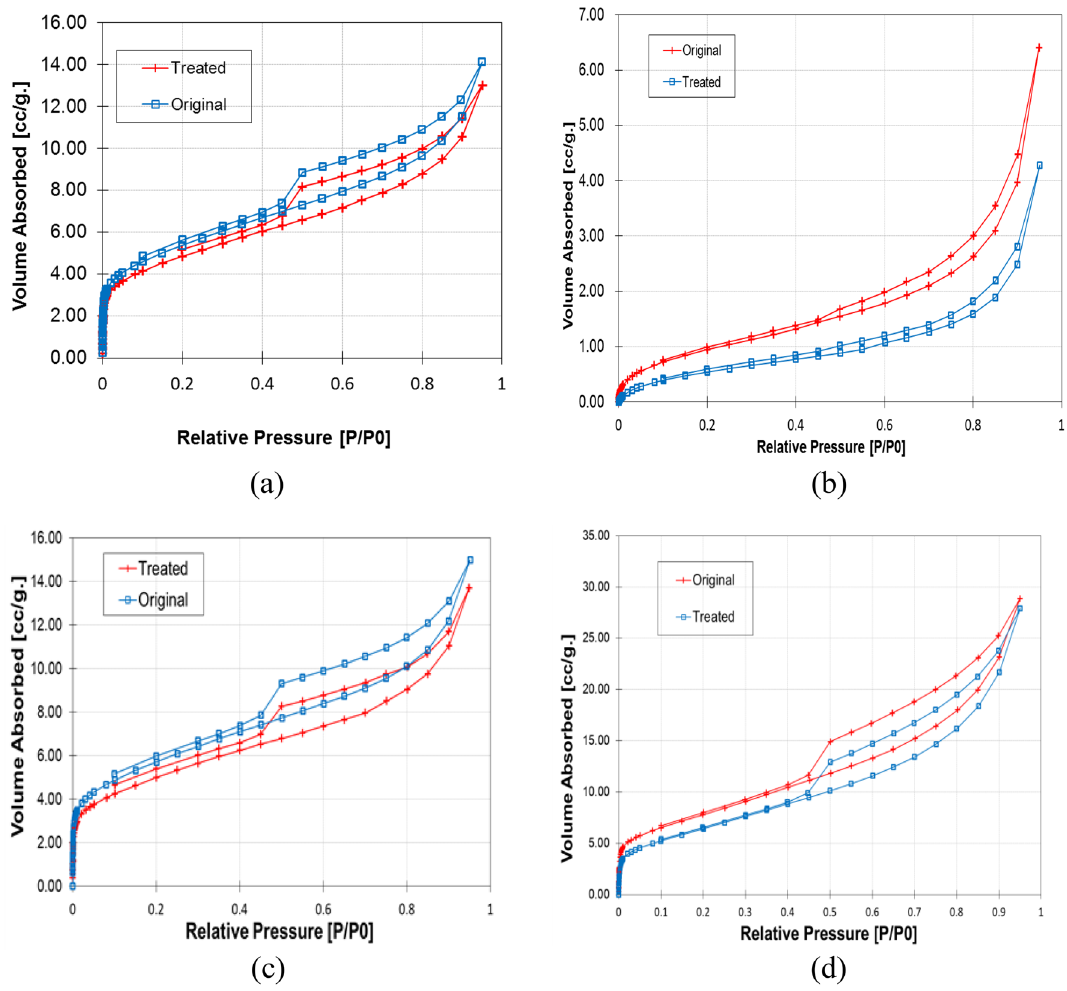
Figure 5. Isotherm Comparison for four shales tested. ( a ) Haynesville Shale. ( b ) Eagle Ford Shale. ( c ) Longmaxi Shale. ( d ) Opalinus